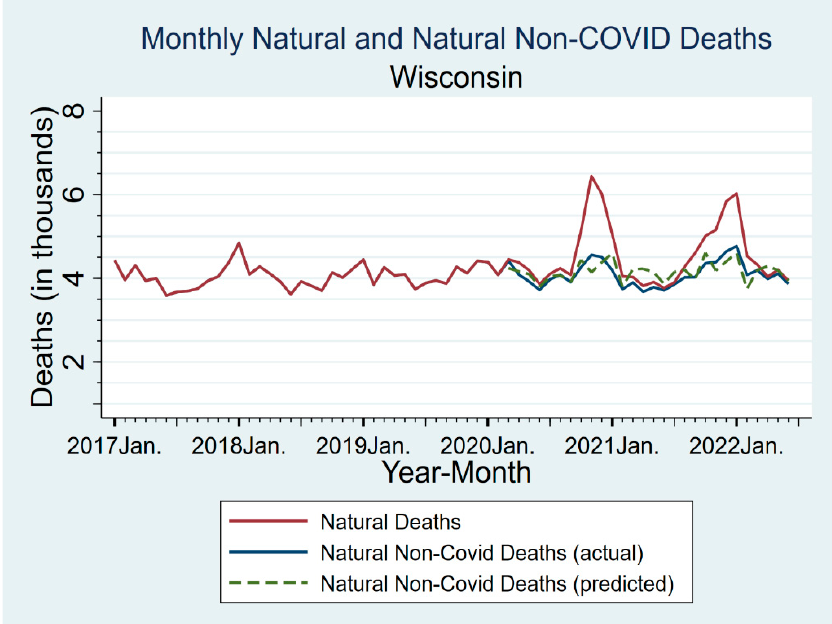
Figure 2. Actual versus Predicted Non-COVID Natural Mortality in Wisconsin. Figure shows monthly data for natural non-COVID and all natural deaths, for Wisconsin for January 2017–June 2022. For the pandemic period starting March 2020, we show both actual and predicted natural non-COVID deaths. Predicted deaths are based on linear extrapolation from 2017–2019 to the same calendar month during the pandemic period. Natural deaths (including COVID-19 deaths) are shown as solid red line; this shows two large COVID-related peaks in late 2020 and late 2021–early 2022. Natural non-COVID deaths (all natural deaths minus COVID-19 deaths) are shown as solid blue line. Predicted natural non-COVID deaths are shown as dashed green line.